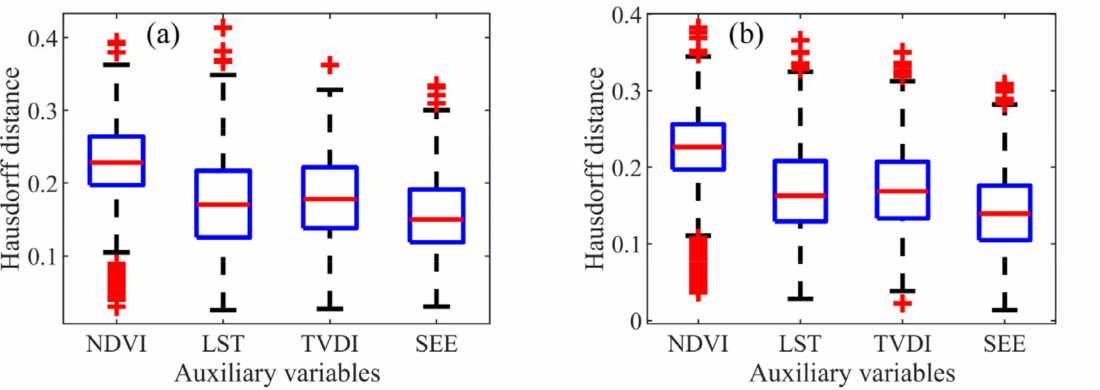
Figure 6. Box and whisker plots of HD between the auxiliary variables and PLMR soil moisture products on the days of 10 July ( a ) and 2 August ( b ) of 2012 (five parameters: median, lower, and upper extremes, and lower and upper quartiles are shown in the figure. The median is plotted as a red line and the box is delimited by the quartiles and the whiskers by the extremes, and the red ‘+’ indicates outliers). Table 1. The standard deviations (STD) of Hausdorff Distance (HD) on 10 July and 2 August, 2012.